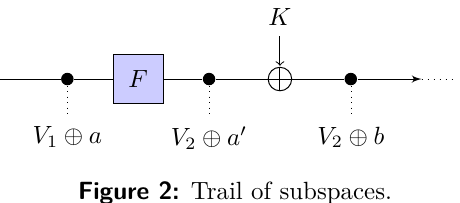
Figure 2: Trail of